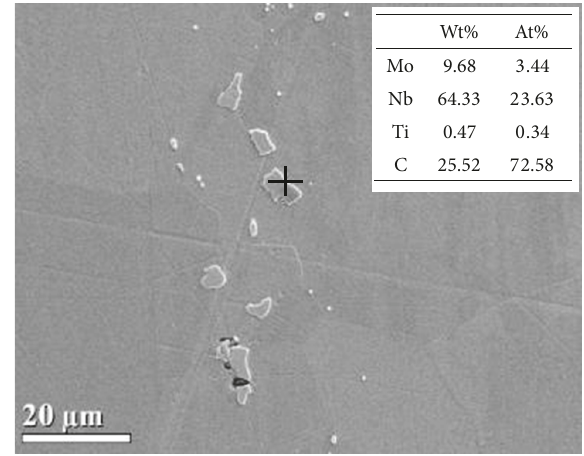
Table 2: Chemical composition of Alloy 625 (wt%).